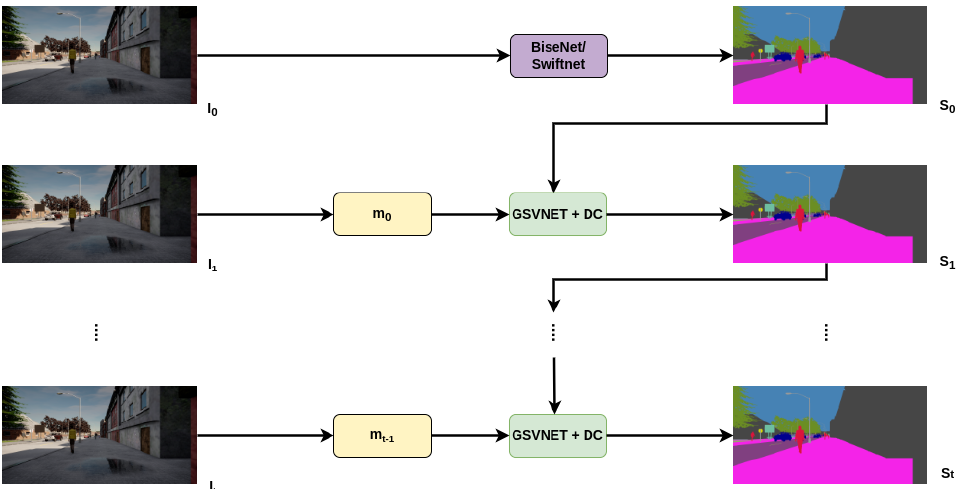
Figure 2. Demonstration of our proposed method. BiseNet/SwiftNet is the base segmentation network, GSVNET with dilated convolution (DC) is the propagation framework. Segmentation prediction maps S from frames I are temporally propagated until the next keyframe is